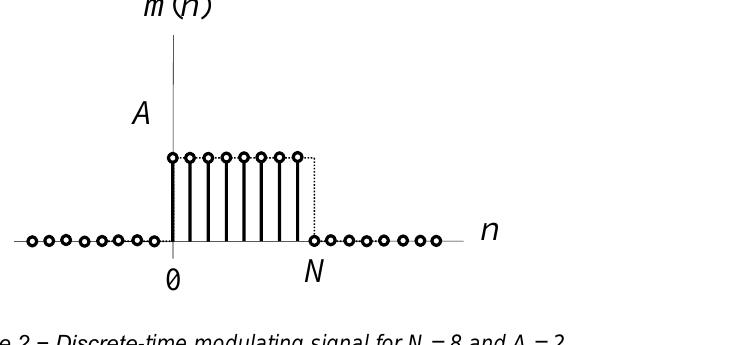
Figure 2 − Discrete-time modulating signal for N = 8 and A = 2. Рис. 2 – Модулирующий сигнал с дискретным временем для N = 8 и A = 2 Слика 2 – Модулишући сигнал дискретног времена за N = 8 и A =